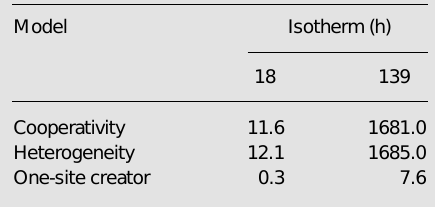
Table 1. The data point to a statistical supe-